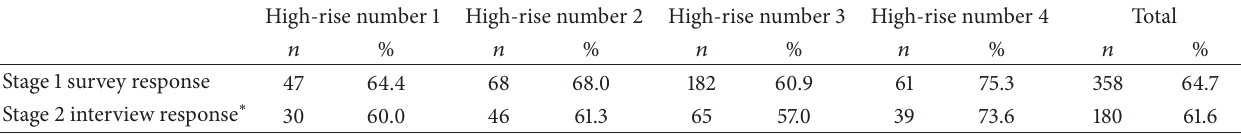
Table 3: Stage 1 and Stage 2 building-specific response